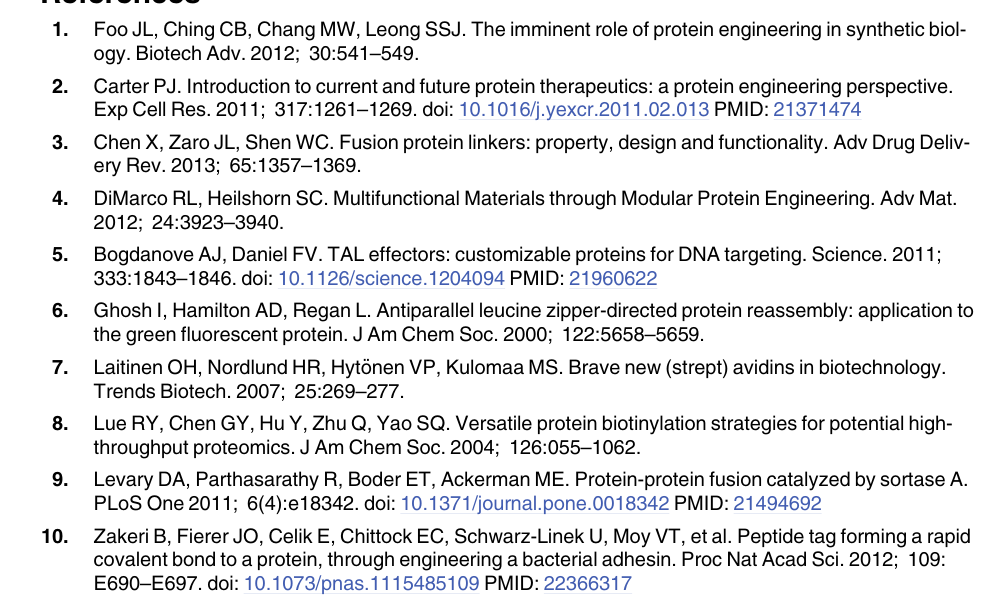
S1 Table. Protein sequencesof constructs used in the